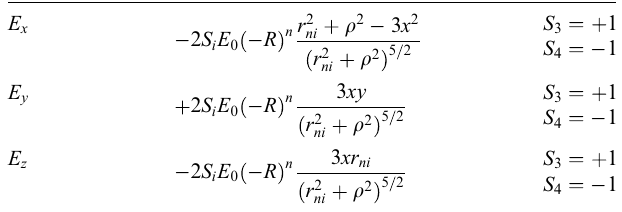
Table 3. Layer-1 secondary field terms for the